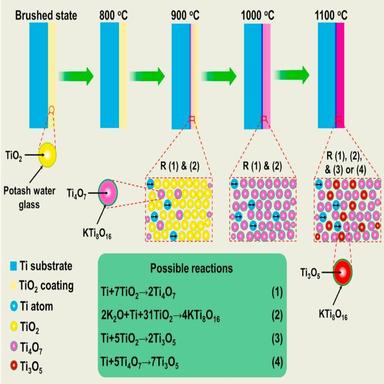
Schematic diagram of the formation mechanism of the Ti4O7-coated Ti substrate.